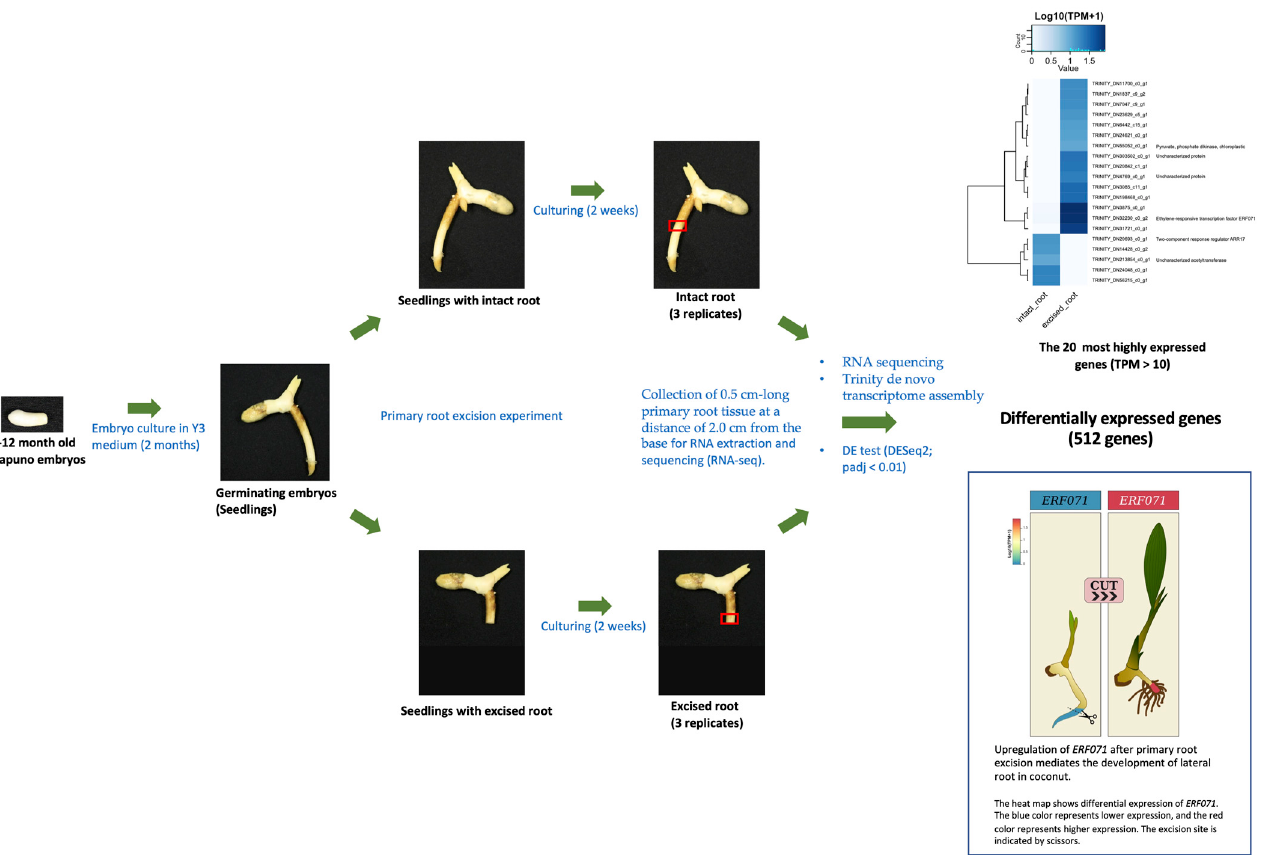
Figure 7. Schematic representation of the primary root excision experiment and transcriptome analysis showing the induction of ERF071 after primary root excision mediating the development of lateral roots in coconut.